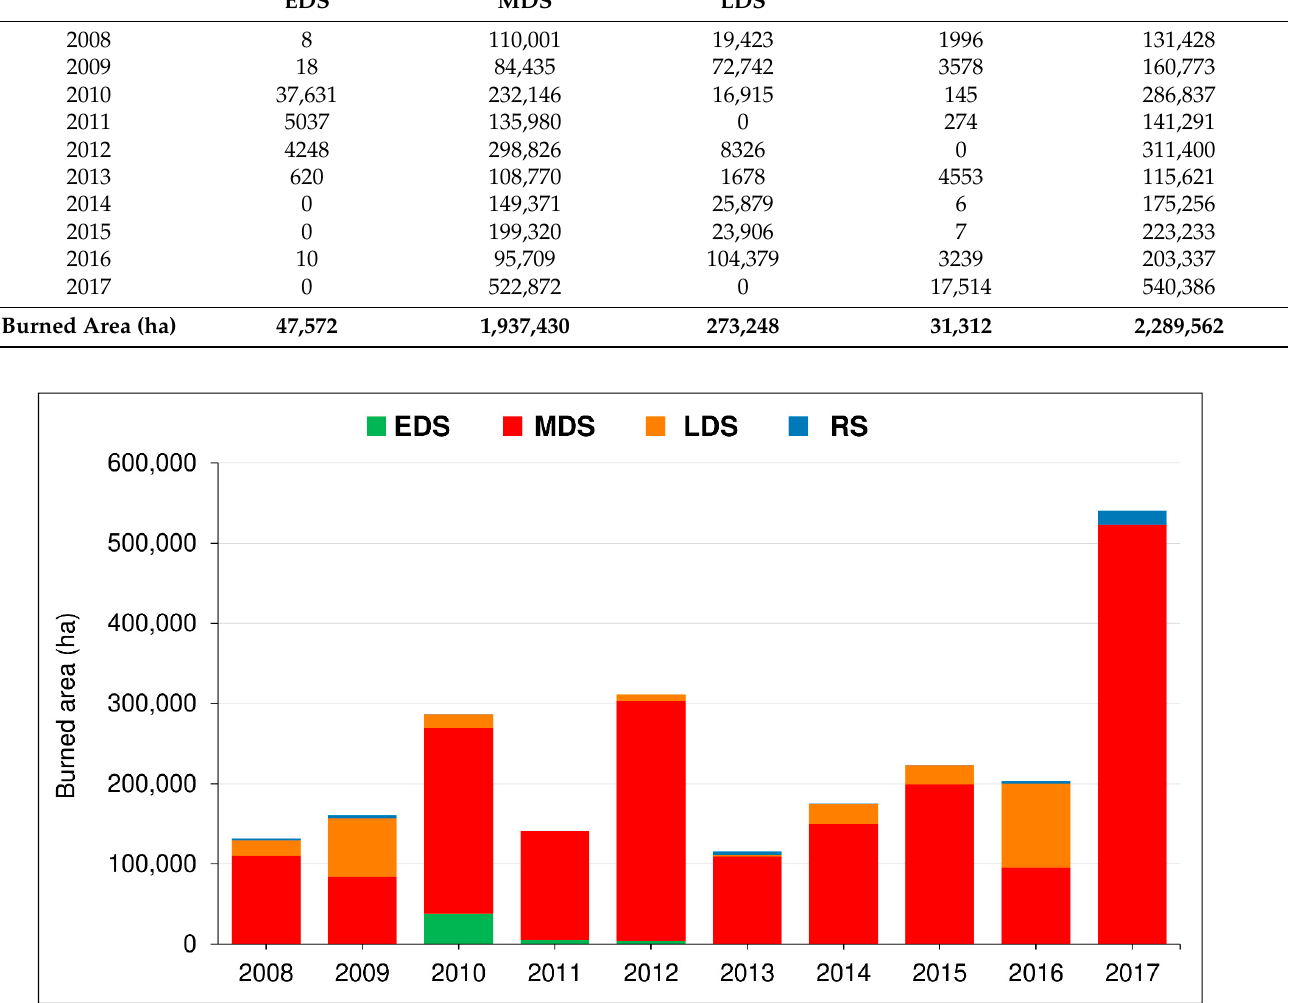
Figure 2. Yearly distribution of burned area categorized by season in the calendar year from 2008 to 2017. The rainy season’s fires occur primarily during the beginning of the rainy season after the dry season of the year labelled on the axis.